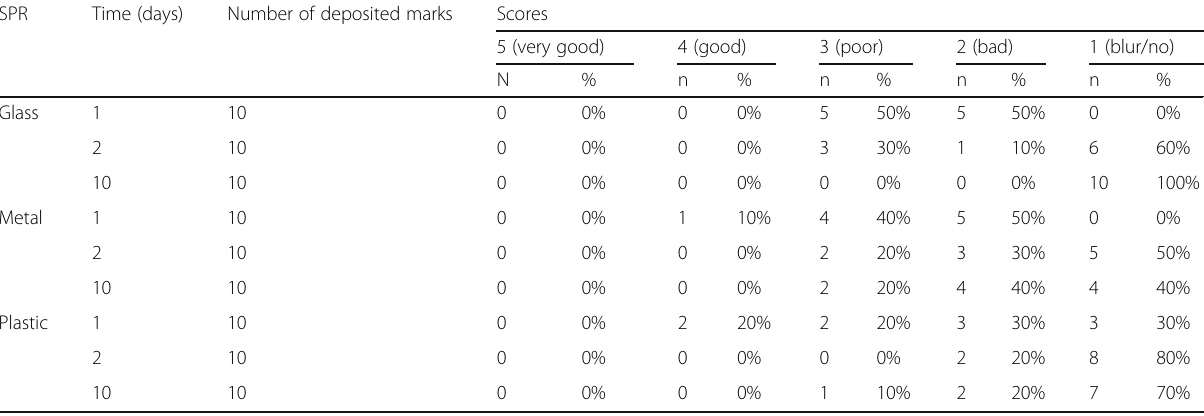
Table 2 Fingerprints development scores using SPR technique on glass, metal and plastic surfaces submerged in sea water at 1, 2 and 10 day ’ s intervals according to fingerprints quality assessment